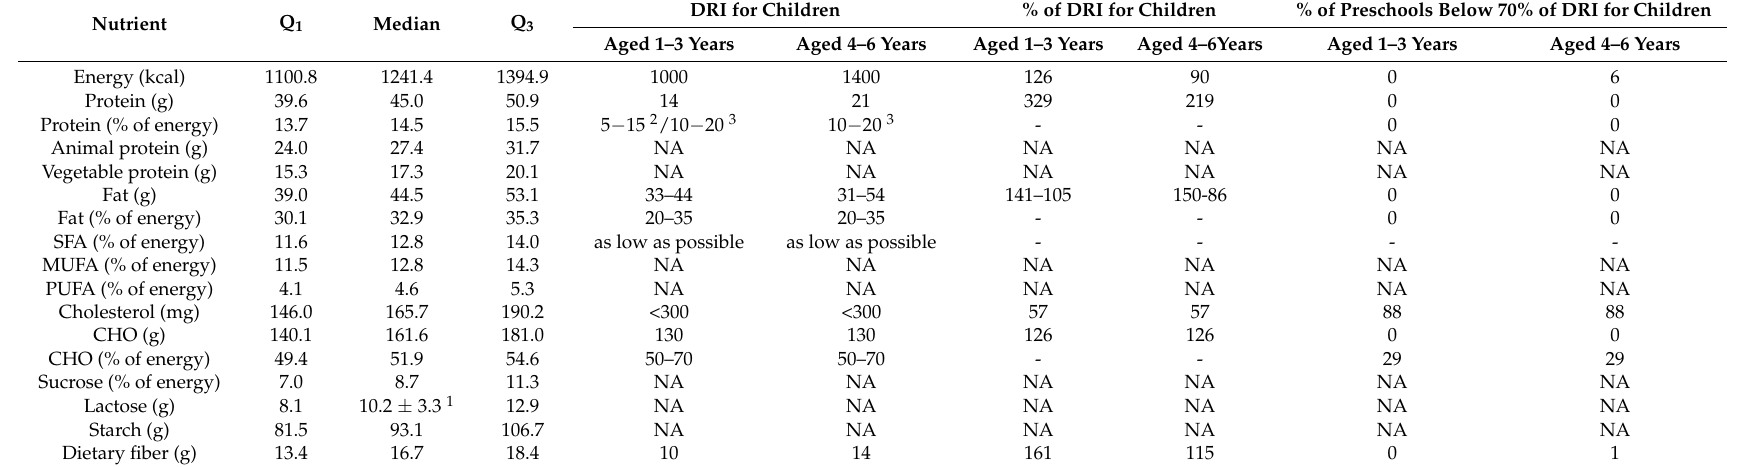
Table 1. Energy and macronutrients provided in preschools ( n = 270) menus per child per day and the age-specific dietary reference intake (DRI). Nutrient Q 1 Energy